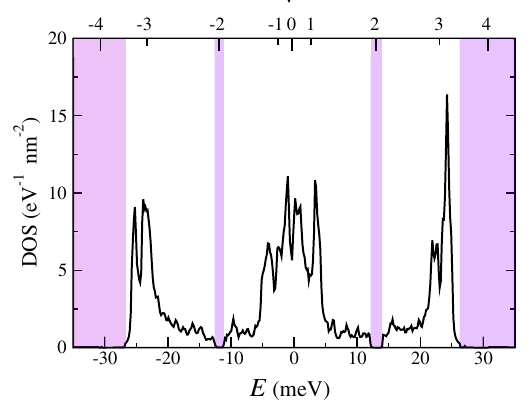
FIG. 9. Density of states in the flatbands region after the TBLG has been distorted by one of the two degenerate modes at M marked by a green arrow in Fig. 5. A mesh of 40 × 40 points in the MBZ has been used. The DOS is expressed as function of energy, the zero corresponding to the charge neutrality point, and corresponding occupancy ν of the FBs. The band gaps at ν ¼ (cid:2) 2 ; (cid:2) 4 are highlighted in violet. The mean displacement per atom is 1.8